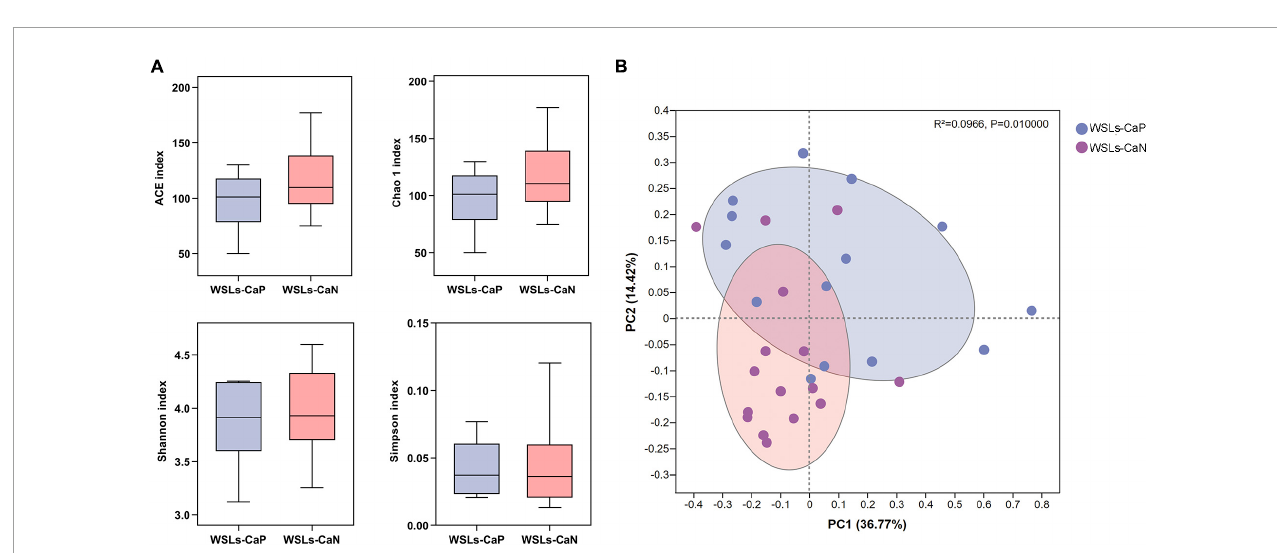
FIGURE4 Comparisons of microbial diversities between WSLs-CaP and WSLs-CaN groups. (A) Alpha diversity was evaluated by indices of ACE, Chao1, Shannon, and Simpson. No significance was detected in all indices. (B) Beta diversity was calculated via the comparison of principal coordinates analysis (PCoA). Each dot represents one sample. The communities in WSLs-CaP group tended to cluster apart from the communities in WSLs-CaN group ( P < 0.05).